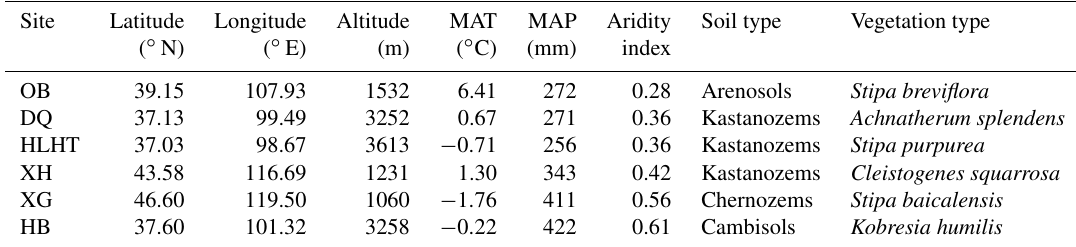
Table 1. Location and basic information of the studied grassland sites.